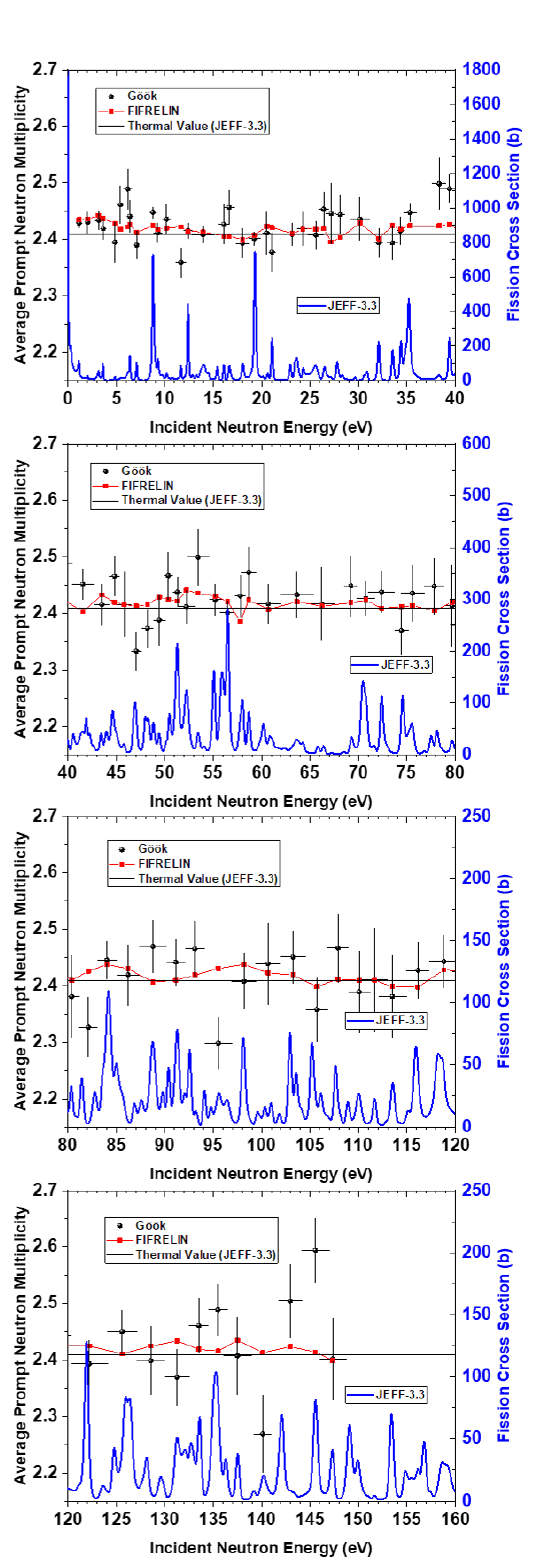
Figure 3. Average prompt neutron multiplicity for the 88 res- onances measured by Göök [9]. For each experimental point (black dots), the horizontal line indicates the energy range con- sidered by the experimentalist while the vertical line corresponds to the statistical uncertainty. The black line gives the thermal ν P - value from JEFF-3.3. The red points were obtained from FIFRE- LIN calculation. Lastly, the fission cross-section given by JEFF- 3.3 is plotted (blue line) and must be read on the right scale.